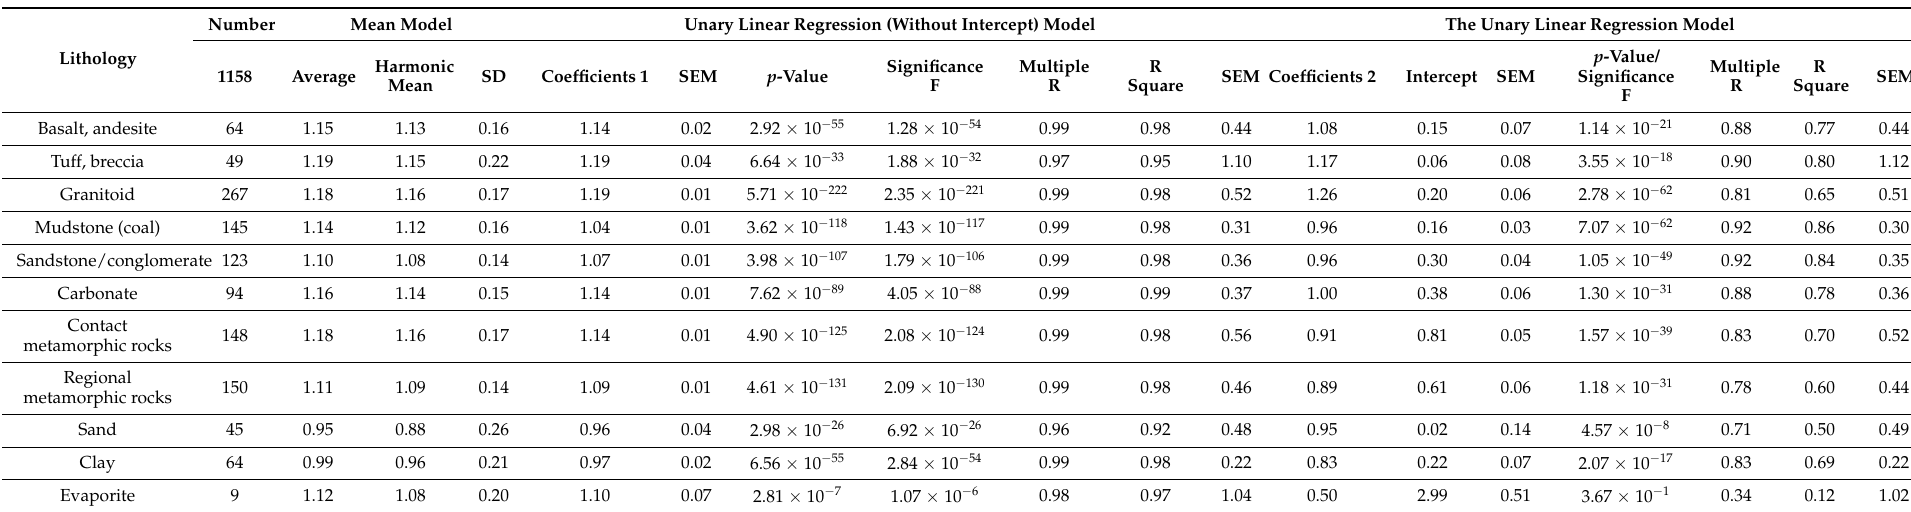
Table 3. Statistics of anisotropic models of thermal